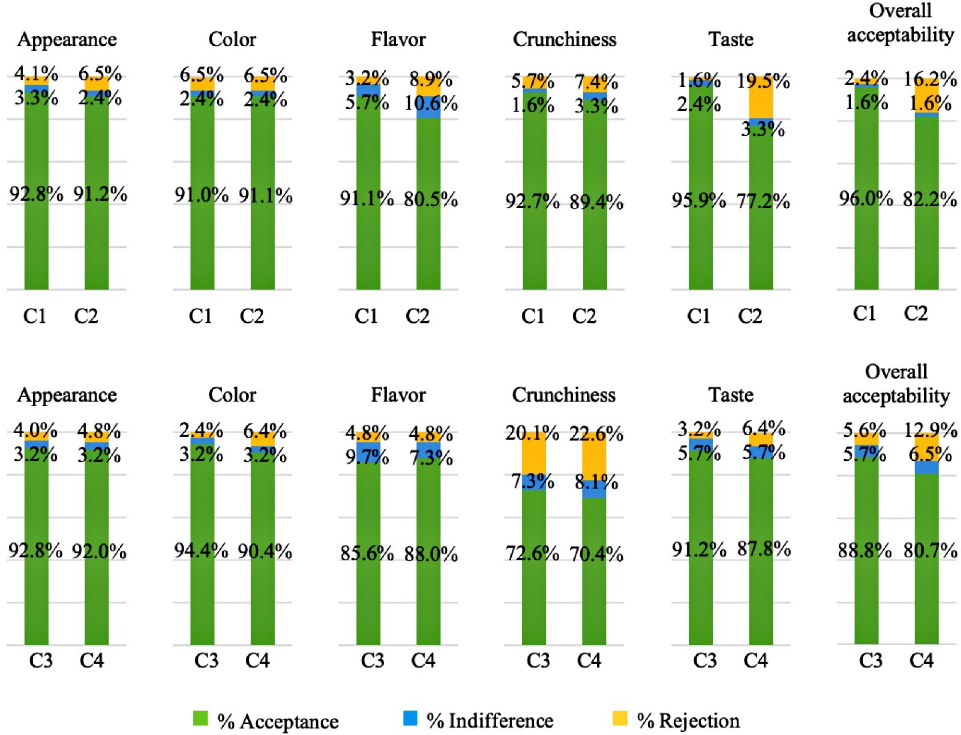
Fig 3. Acceptability of the appearance, color, flavor, crunchiness, taste and overall acceptability of the cookies. Acceptance, indifference, and rejection percentages for the acceptability of the appearance, color, flavor, crunchiness, taste and overall acceptability of the cookies. C1—wheat flour cookies (control1), C2–50% xiquexique flour (100 mesh) cookies, C3—whole wheat flour cookies (control2) and C4–50% whole xiquexique flour (28 mesh) cookies.